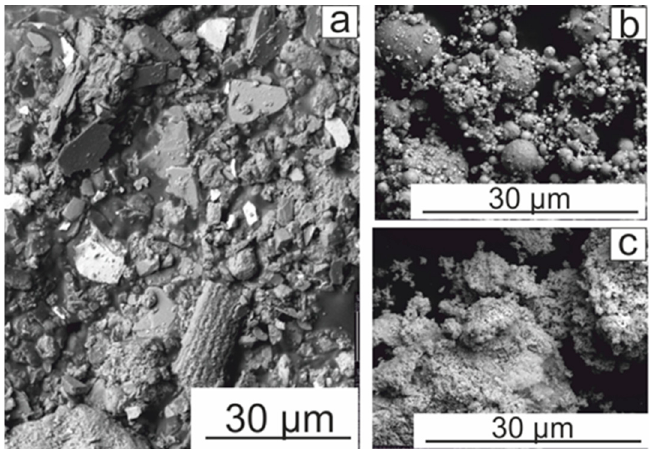
Figure 10. Different morphology of collected PM from the mining area (from crushers), and from the smelter area. ( a ) Coarse grained dust from crusher, Chingola area, ( b ) spherical particles of chalcantite (CuSO 4 · 5H 2 O) from the Pierce-Smith convertor, and ( c ) clusters of fine metalliferous dust particles from the electric furnace, the Nkana Smelter, Kitwe area. SEM, back-scattered electrons. Modified after K ř íbek and Nyambe [93].